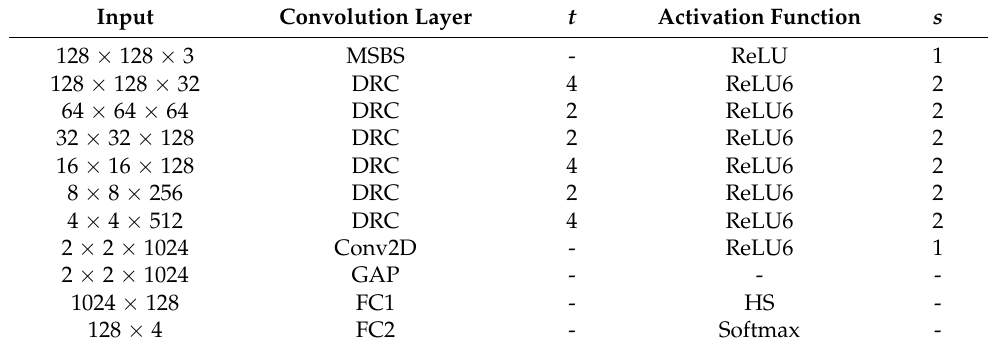
Table 1. T model structure